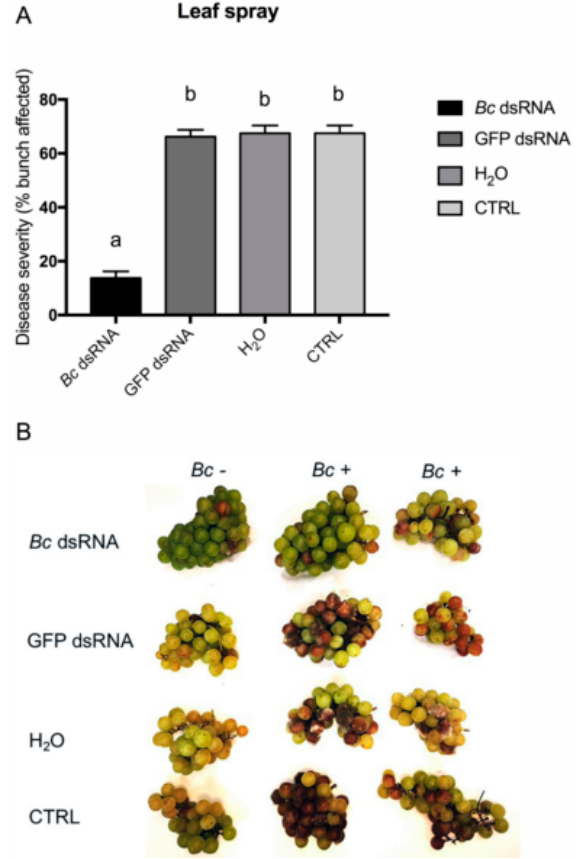
Figure 3. Disease severity on bunches recorded for the in vivo high pressure leaf spray application method. Percentage of berries affected following Bc dsRNA, GFP dsRNA, H 2 O application, and in untreated CTRL samples. Different lowercase letters above bars indicate significant differences as determined by Tukey HSD test ( p ≤ 0.05) ( A ). Overview of representative samples for each condition tested. One bunch was maintained as uninoculated control ( Bc − ) and two inoculated ( Bc +) bunches of cv. Moscato are shown ( B ).